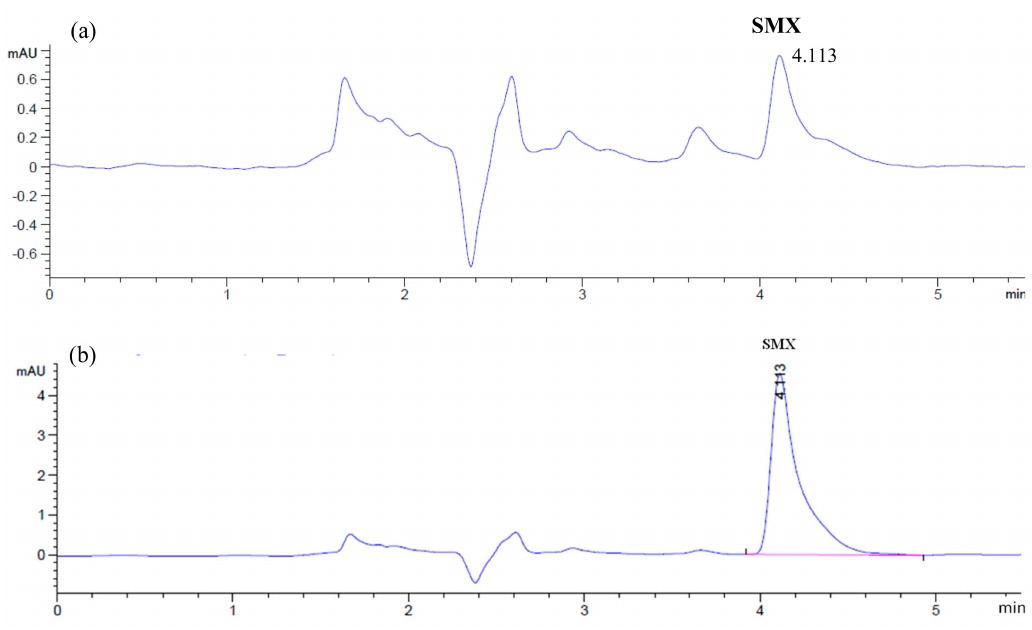
Figure 5. HPLC tests of ( a ) 1 mg/L, and ( b ) 10 mg/L SMX after adsorption and degradation by Ag@Ag 2 O-G2 under visible